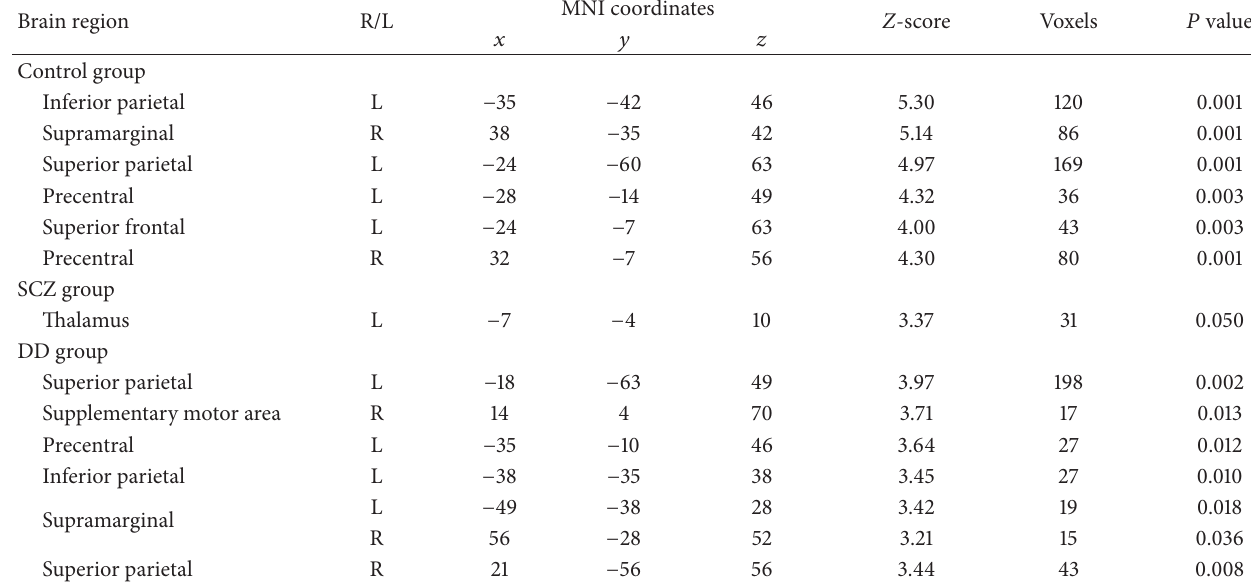
Table 3: ROI activations during the mental rotation task (experimental relative to control condition) in the 3 groups (1-sample student’s 𝑡